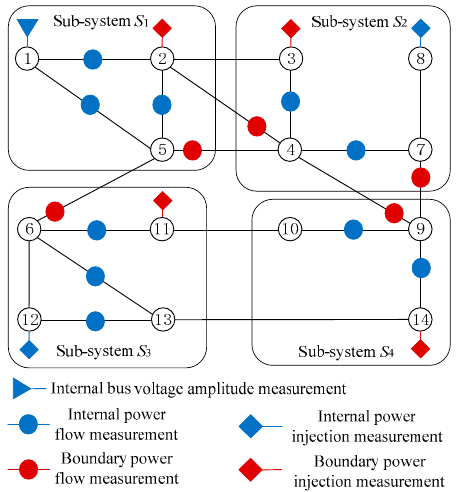
Figure 2. Partition areas and measurement configuration of the IEEE 14-bus system.